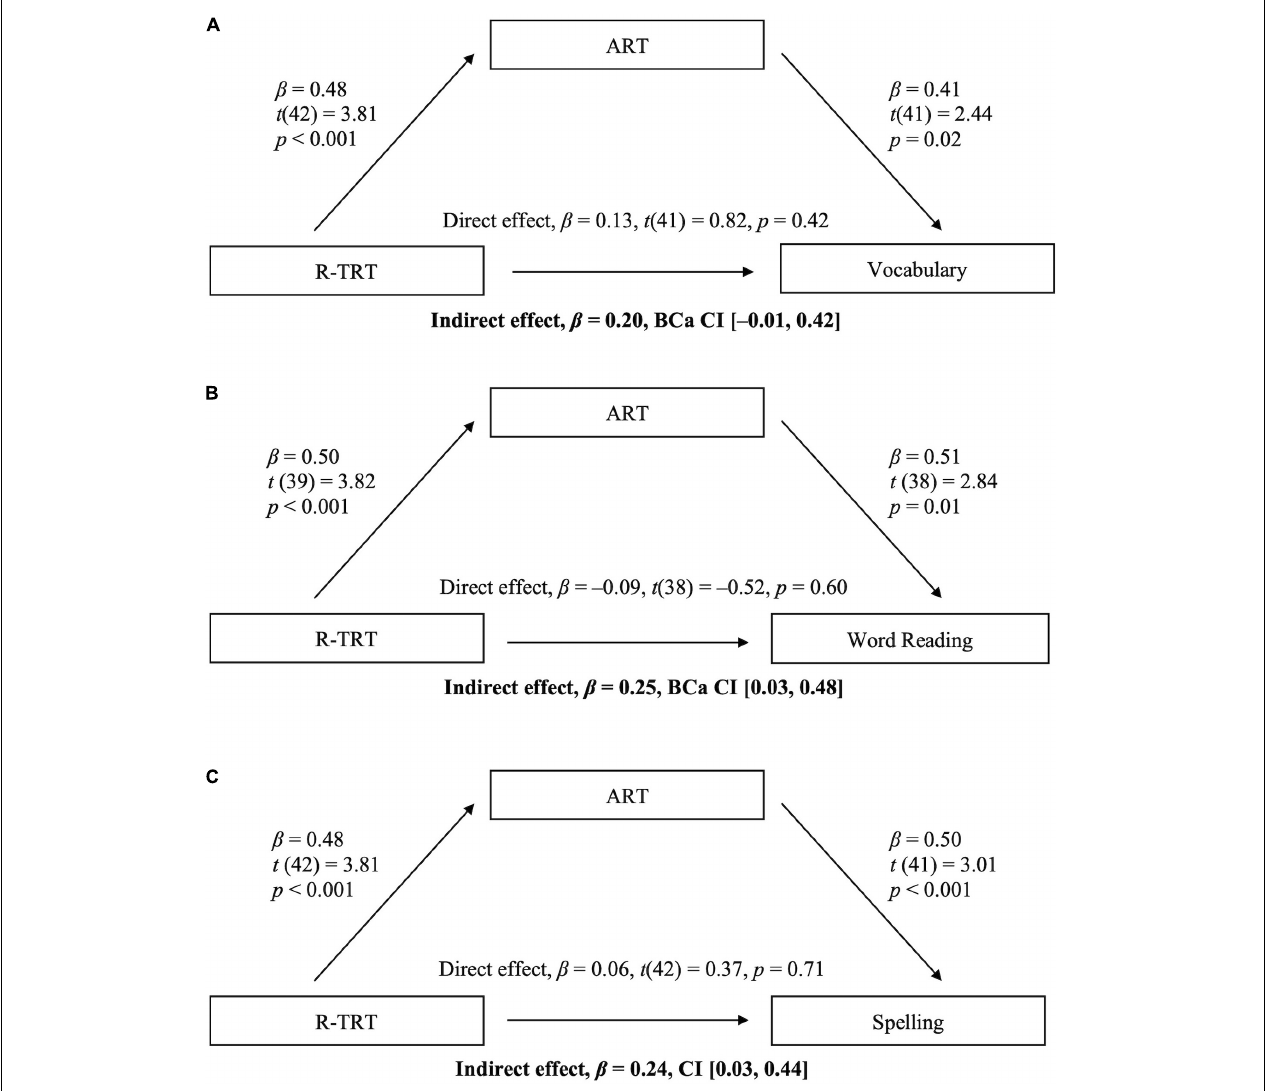
FIGURE 1 | Mediational model for the association between the R-TRT and literacy skills mediated by the ART (controlling for adolescent’s